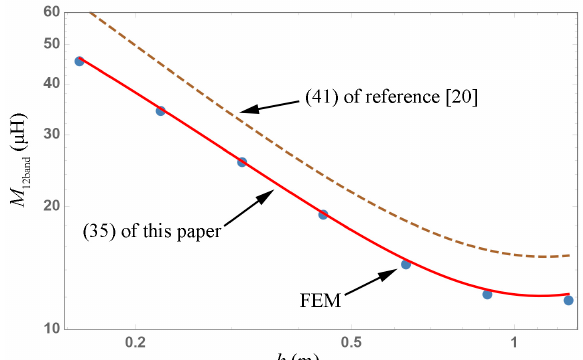
M ) of tape coils with equal 12band